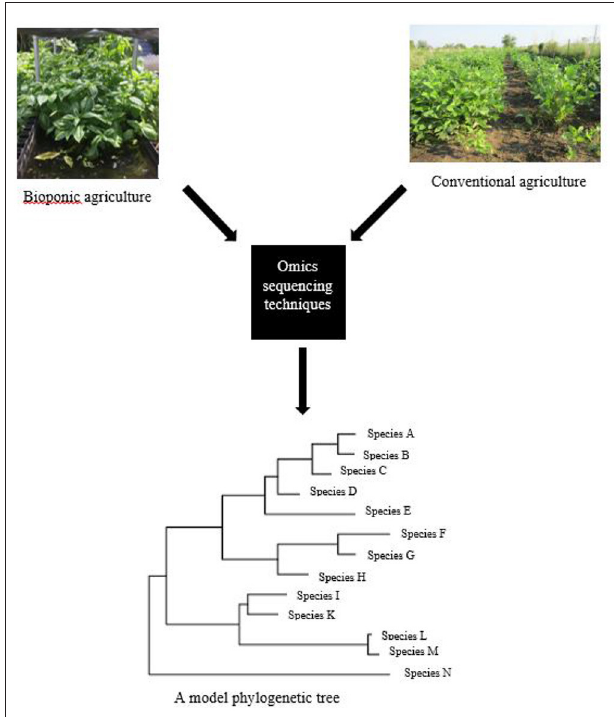
FIGURE 3 | A phylogenetic tree of microbial species obtained from omics analyses of urban and conventional agriculture. Root associated samples of bioponic plants and rhizosphere soil samples can be obtained and sequenced using omics techniques, followed by construction of a phylogenetic tree of the microbial species that are of importance in achieving sustainable